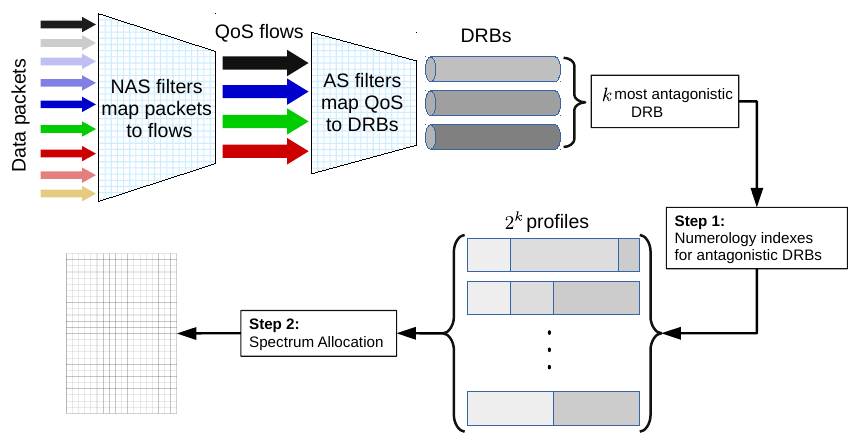
Figure 2. The two-step solution of the numerology selection problem. NAS, non-access